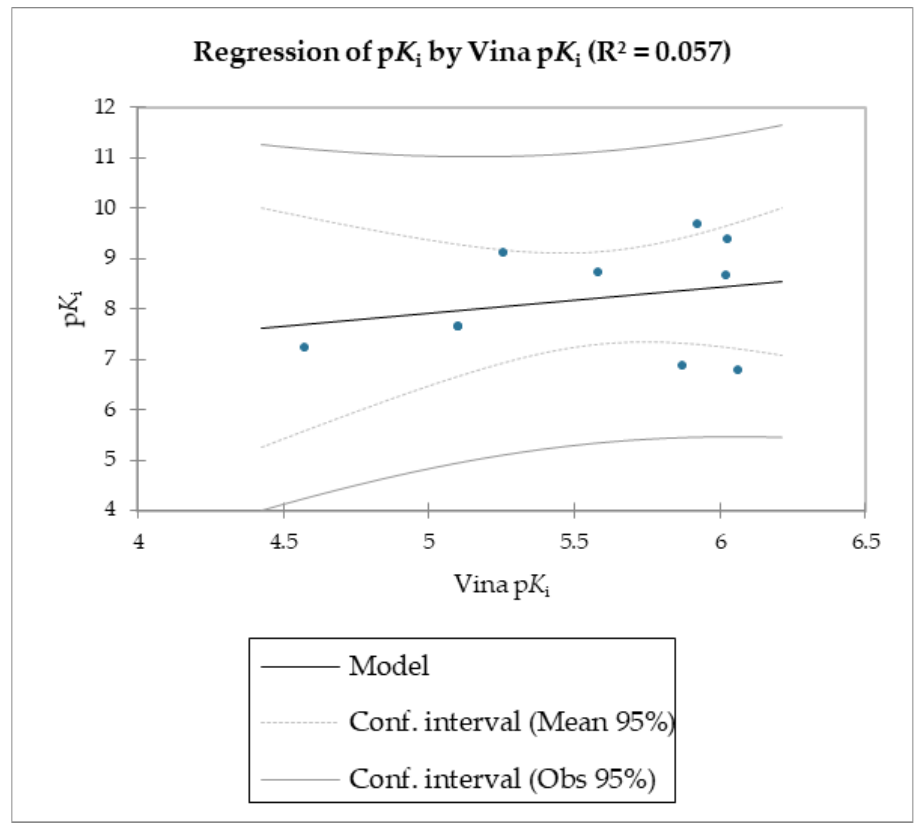
Figure 4. Regression of p K i with Vina - calculated p K i . Table 4. Goodness of fit statistics (Autodock p K i ).